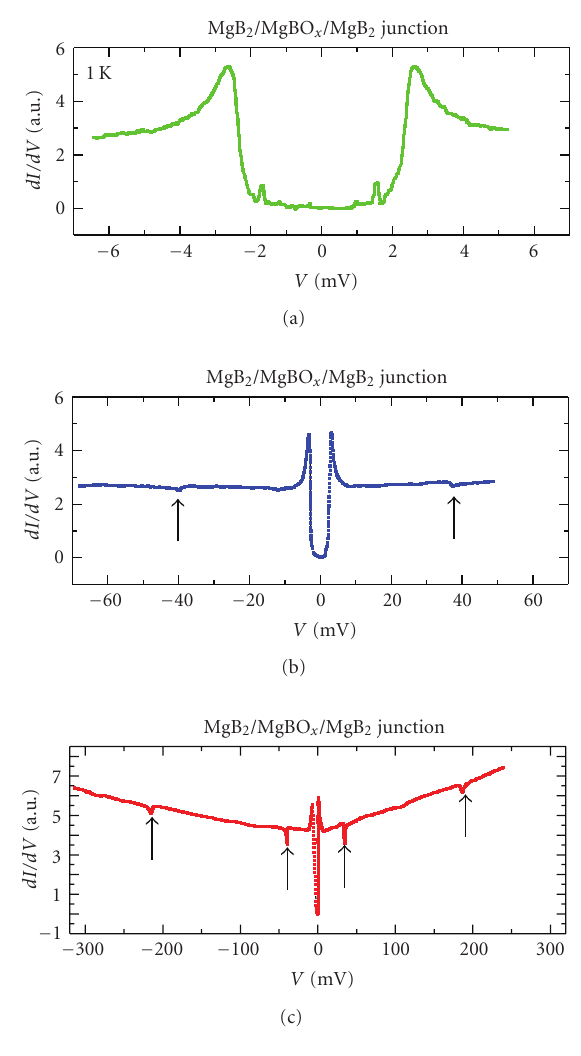
Figure 10: Tunneling characteristics of a MgB 2 /MgBO x /MgB 2 tunnel junction. The dips in the conductance curve correspond to phonon interactions in the